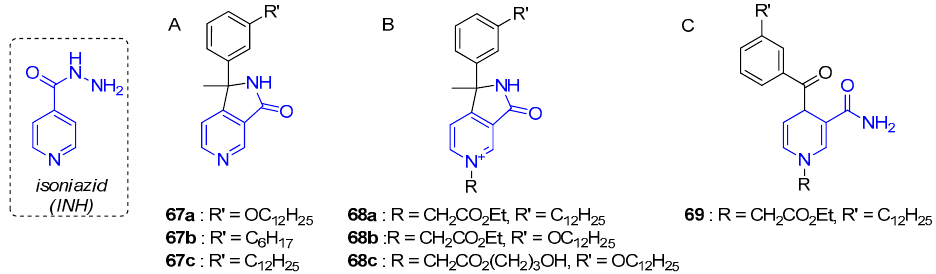
Figure 15. Three classes of isoniazid-nicotinamide adduct analogs developed as inhibitors of InhA from Mycobacterium tuberculosis : A - pyridine, B - pyridinium, C - dihydropyridine; and structure of the most relevant inhibitors [79,80].